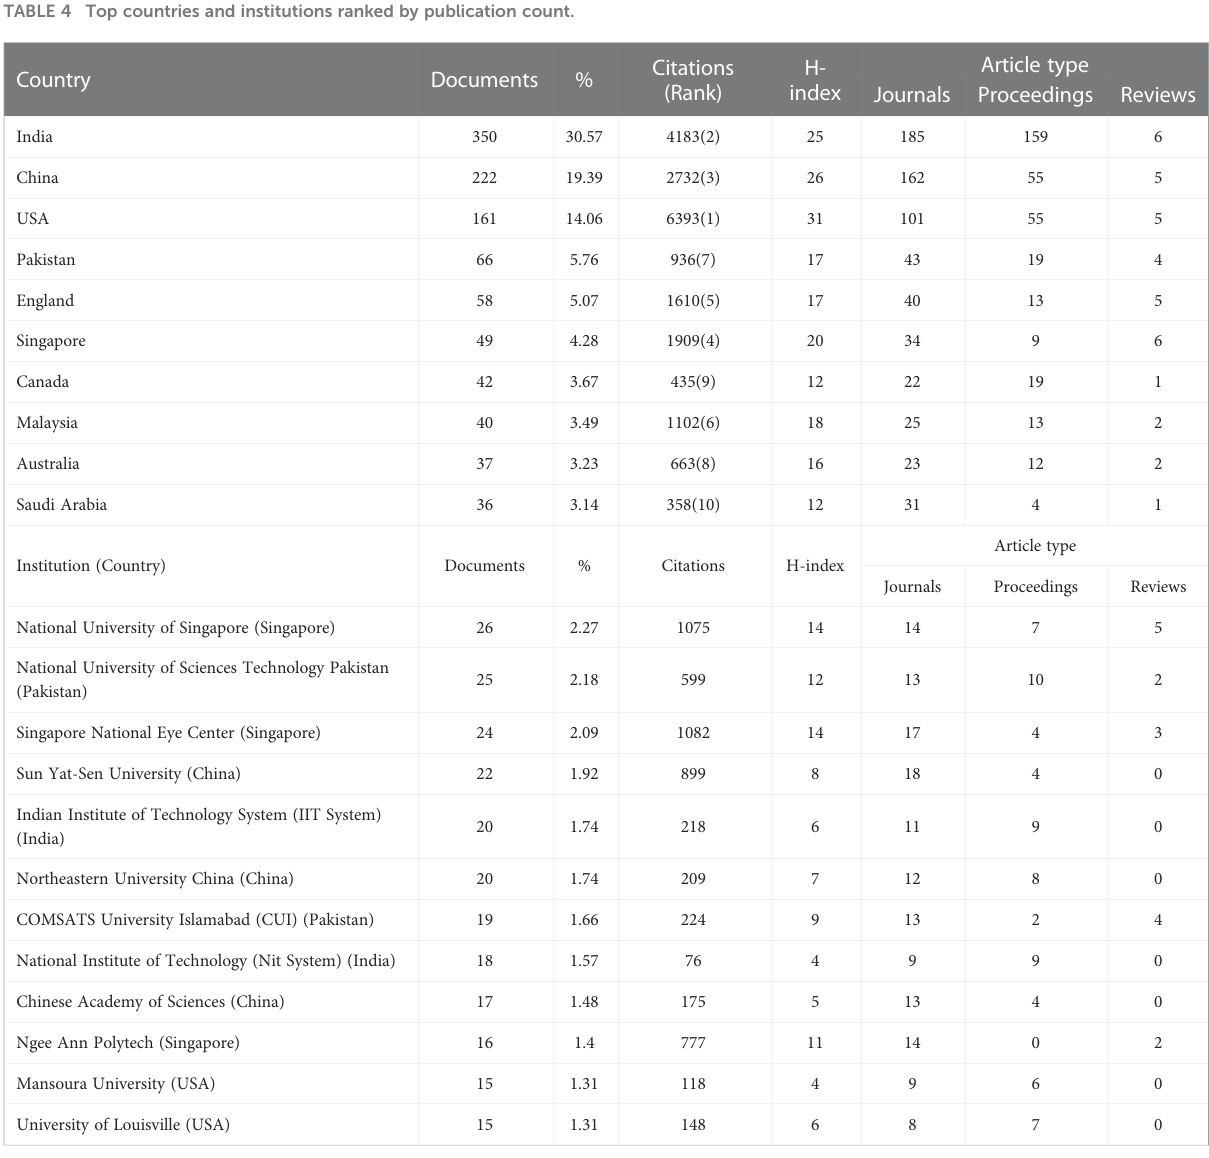
TABLE 4 Top countries and institutions ranked by publication